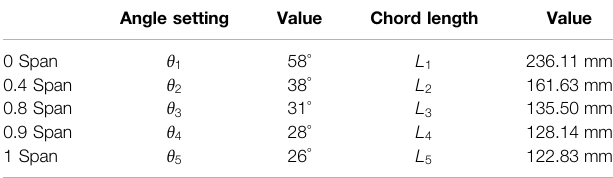
TABLE 1 | Speci fi c blade parameter